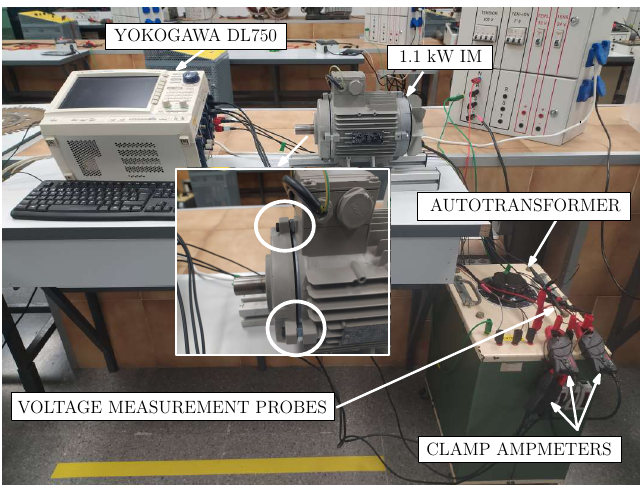
Figure 12. Experimental setup used for validation of the methodology. The zoom shows the IM hood fastener holes drilled to allow for static eccentricity faults.